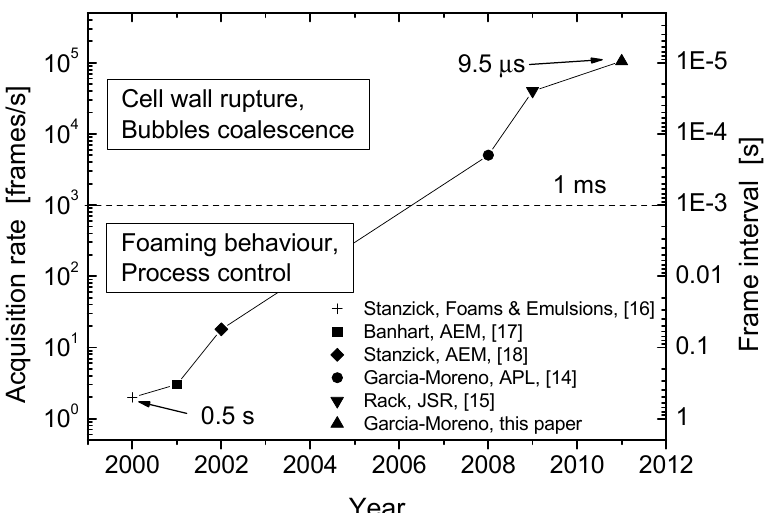
Figure 1. Evolution of time resolution for in-situ synchrotron X-ray radioscopy applied to visualize metal